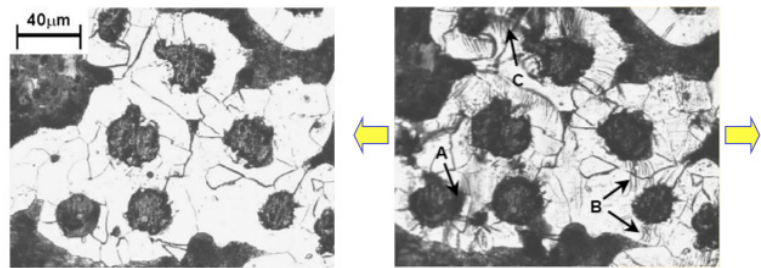
Figura 10: Meccanismi di danneggiamento in una ghisa nodulare ferritico/perlitica;